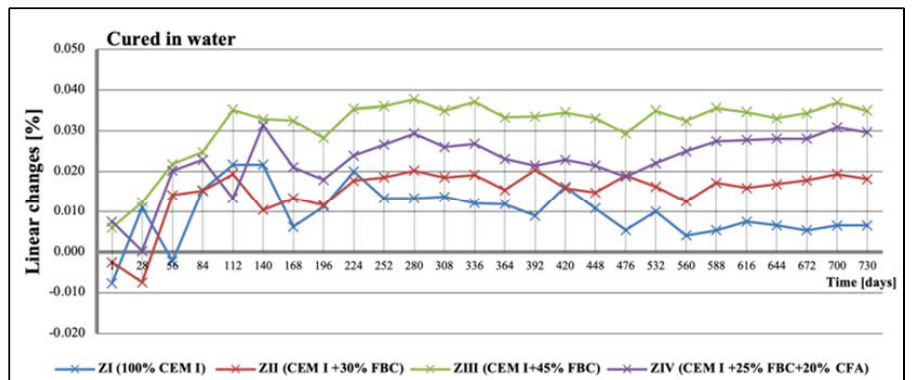
Figure 11. Linear changes of mortars cured in water for 730 days.